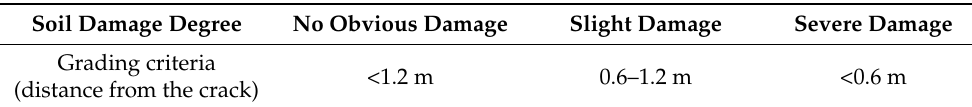
Figure 9. The results of soil moisture content measurements for loess and sandy soil at different distances from the crack. Table 7. The results for the construction of grading criteria for the degree of soil damage.